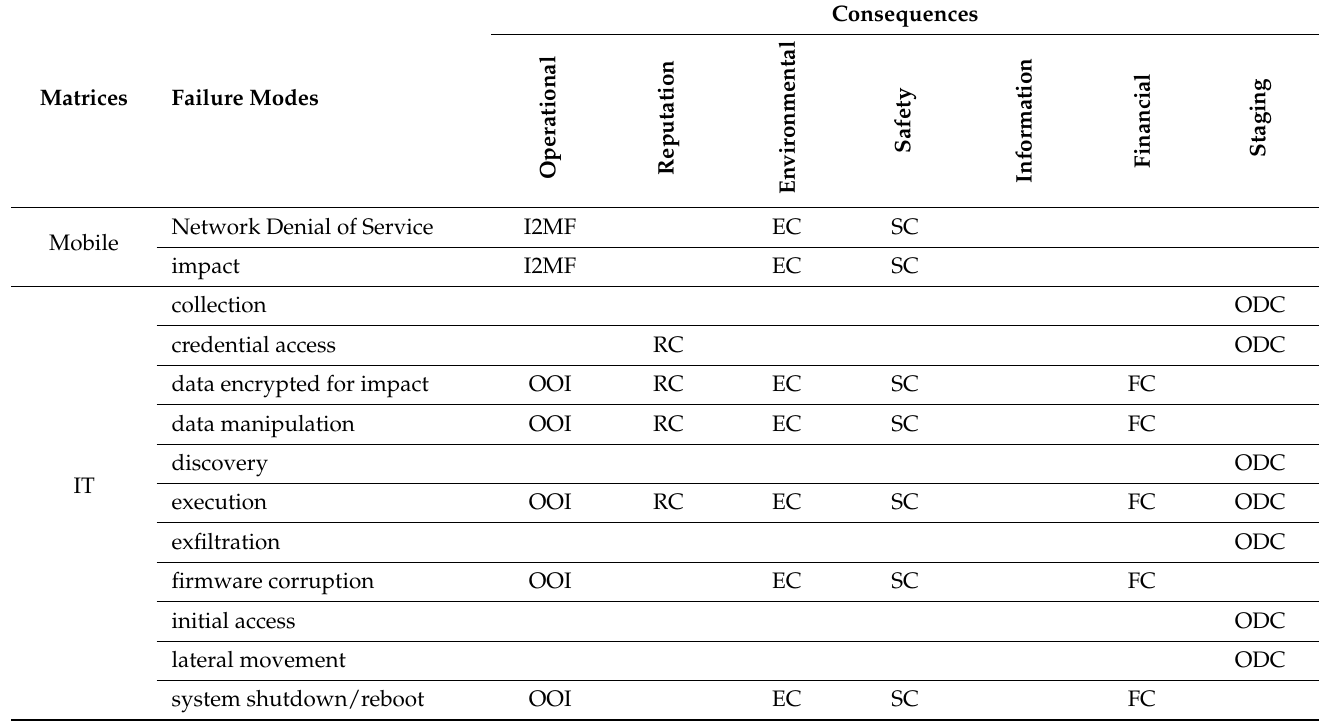
Table 4. Mapping failure modes, consequences, and